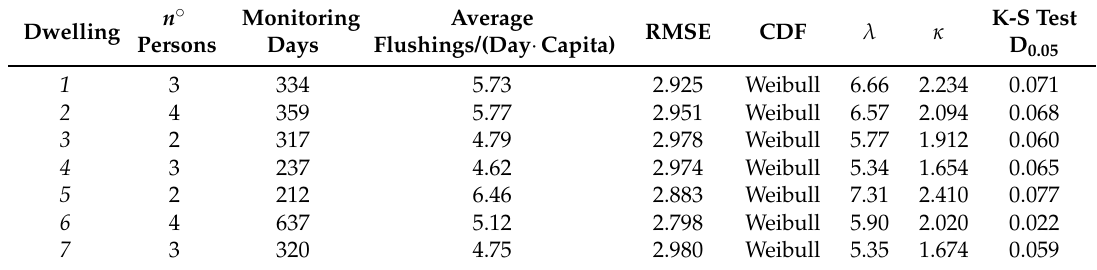
Table 1. Results of statistical analysis carried out on water consumption data collected for seven dwellings located in Palermo and monitored throughout